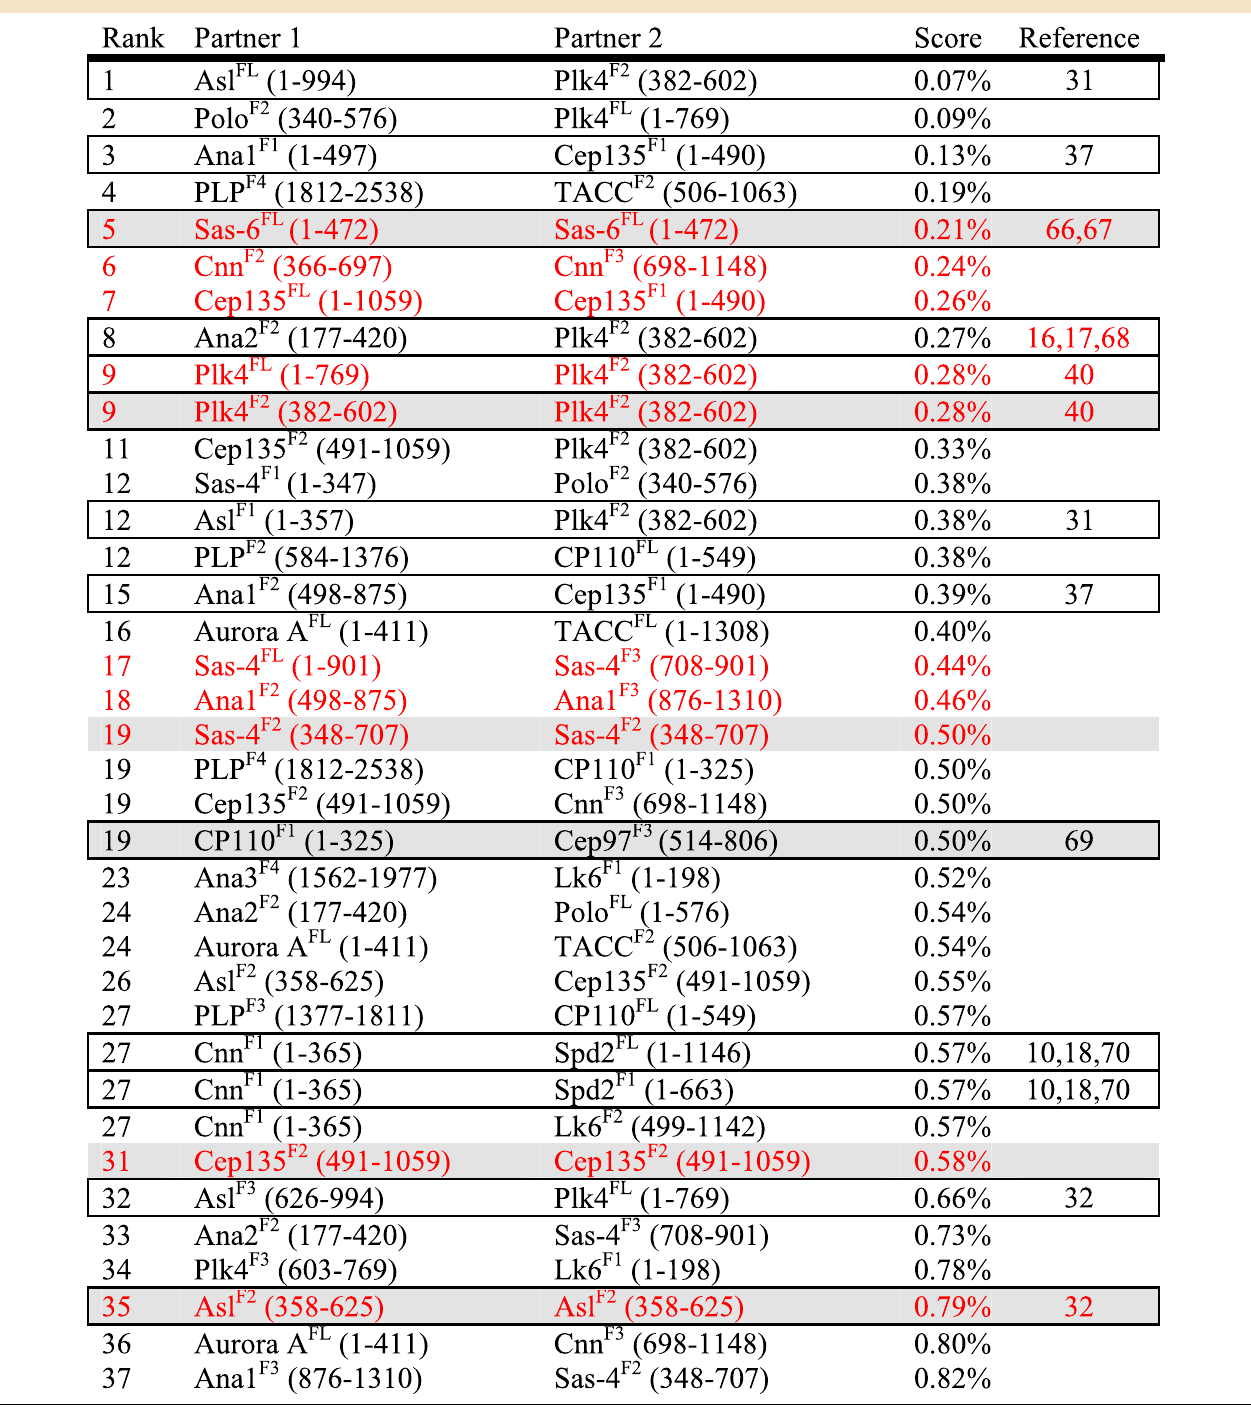
Table 1 | Top 20% (HCIs